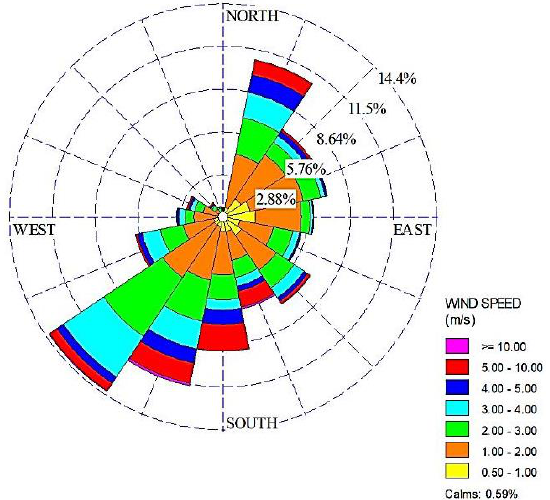
Figure 2. Wind rose of meteorological data gathered at meteorological station located in ENEA RC Portici over 2019.